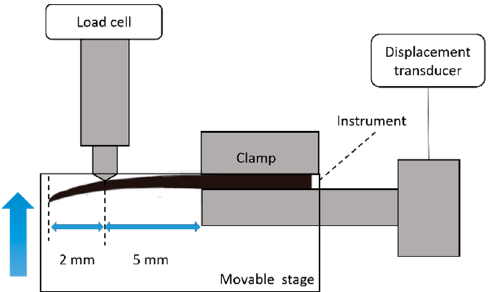
Figure 1. Schematic drawing showing the cantilever bending tester used in the experiment.